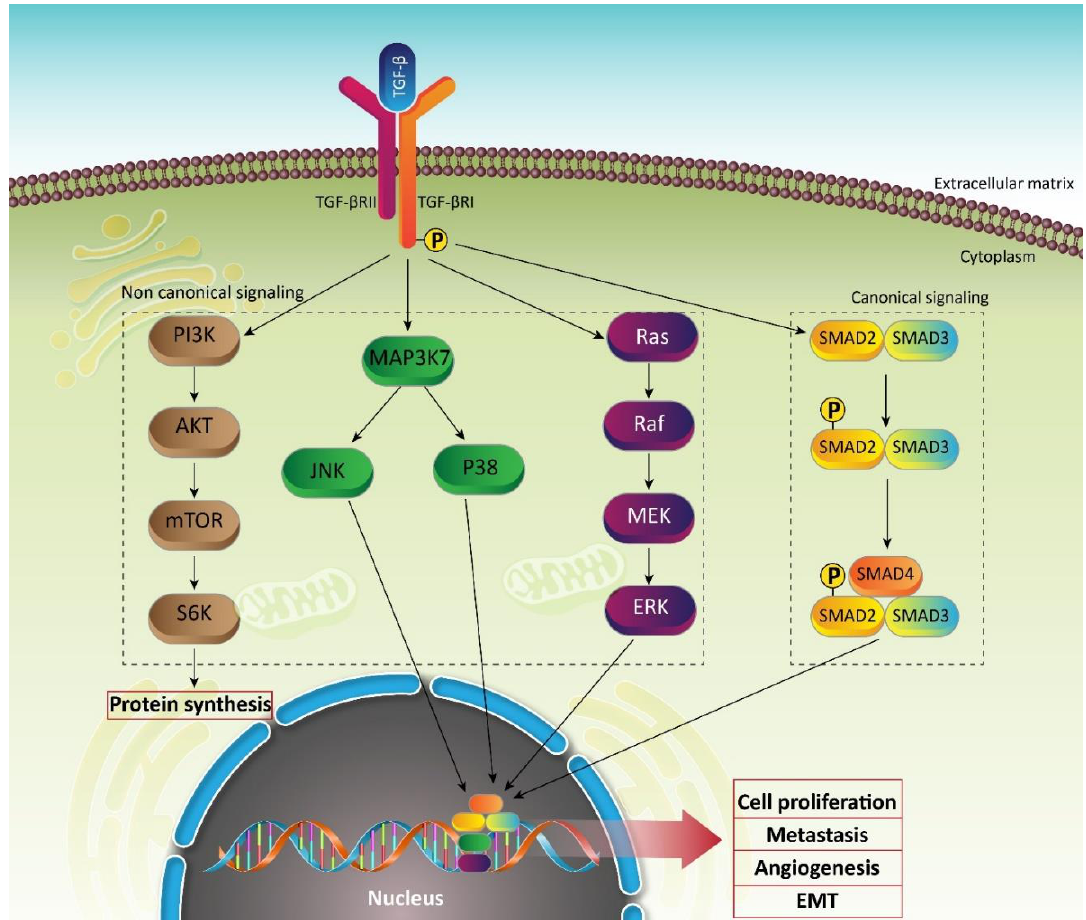
Figure 1. A schematic presentation of transforming growth factor-beta (TGF-β) signaling pathways.